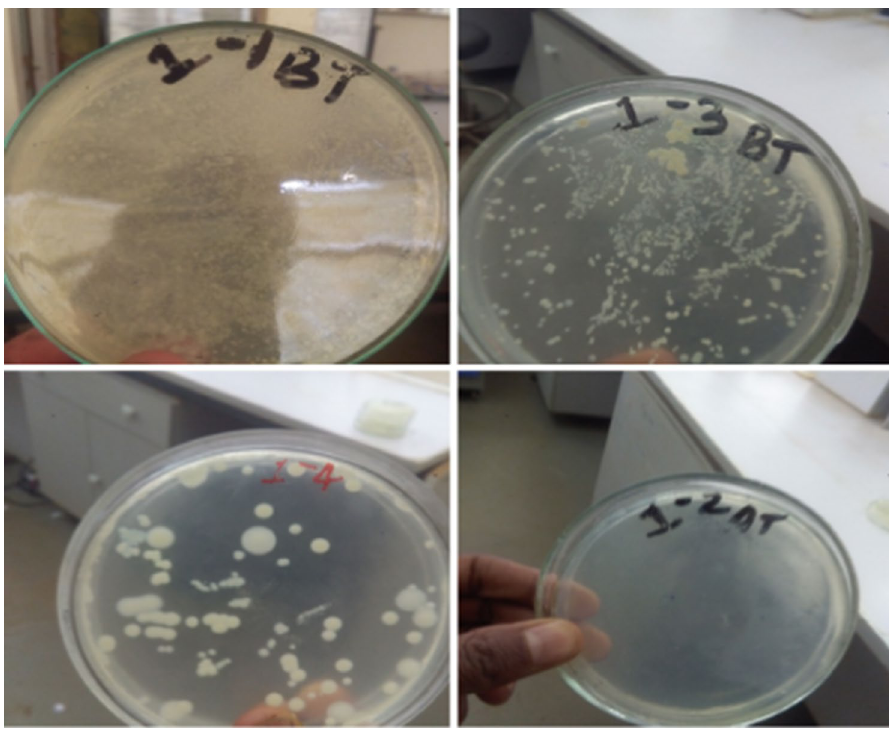
Fig. 3 Total coliform before and after chlorination in the plated petri